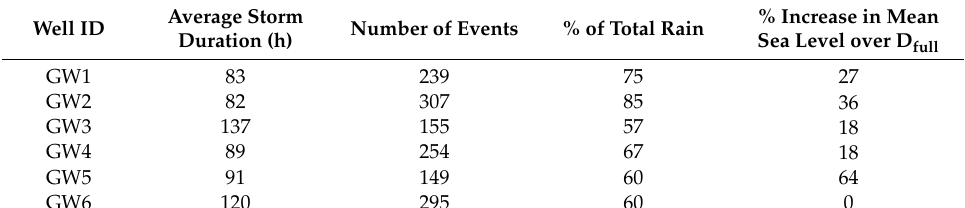
Table 7. Storm characteristics for each well.